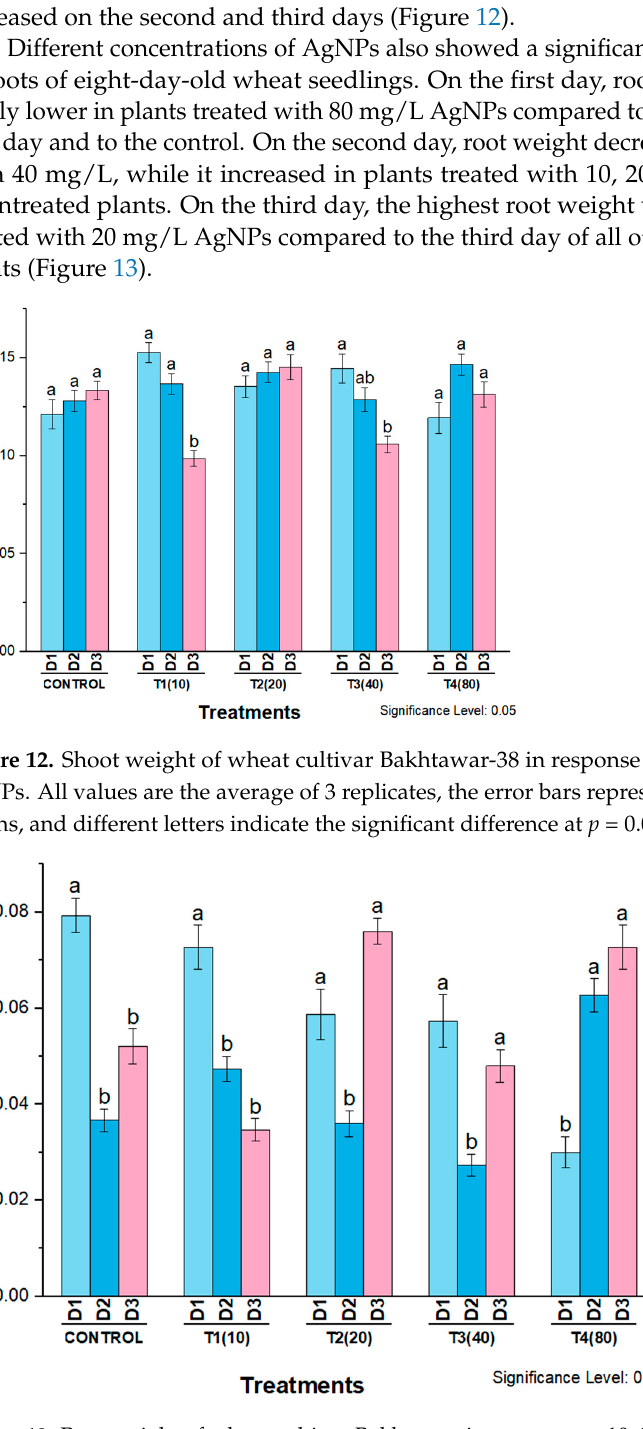
Figure 11. Plant weight of wheat cultivar Bakhtawar-38 in response to 10, 20, 40, and 80 mg/L of AgNPs . All values are the average of 3 replicates, the error bars represent the standard errors of the means, and different letters indicate the significant difference at p = 0.05 by LSD test in each group.